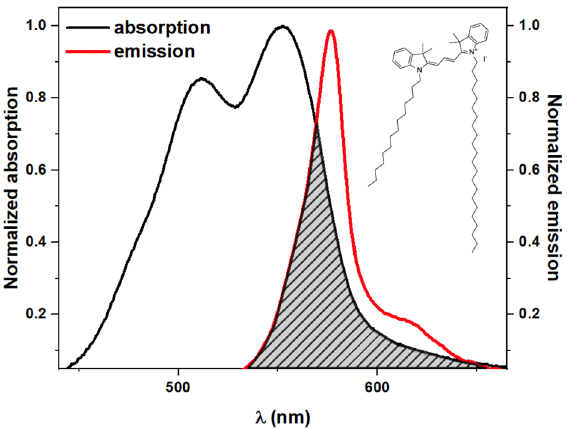
Figure 1. Chemical structure, absorption, and emission spectra of the PKH26 probe.